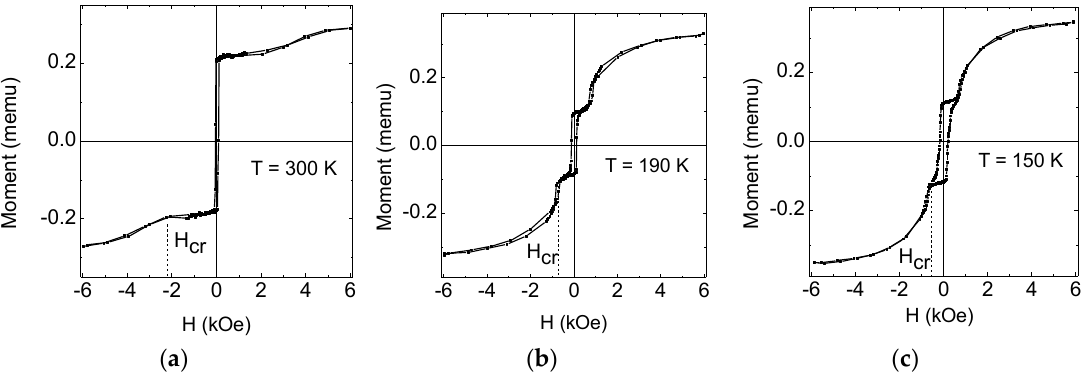
Figure 3. VSM hysteresis loops for Gd-Co(35 nm)/Co(7 nm)/Cu(4 nm)/Co(7 nm) spin valve multilayered element measured at different temperatures: ( a ) 300 K; ( b ) 190 K; ( c ) 150 K.